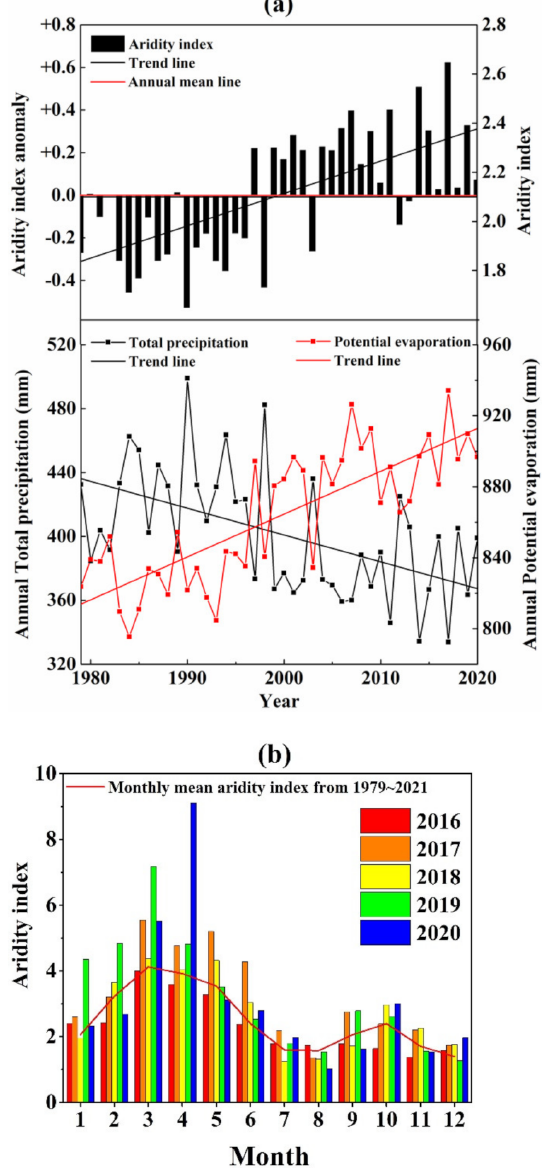
Figure 2. Temporal distribution of the aridity index, potential evaporation and total precipitation over the MP and surrounding areas. We used the linear regression method to calculate trends. ( a ) Annual mean aridity index, potential evaporation and total precipitation during the 1979–2020 period. The aridity index is expressed as the ratio of potential evaporation and total precipitation. ( b ) Monthly mean aridity index during the period